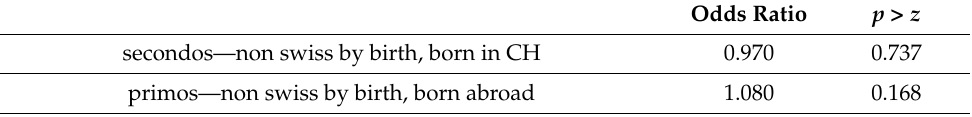
Table 2. Non ‐ affiliation—GEE logistic regression coefficients.